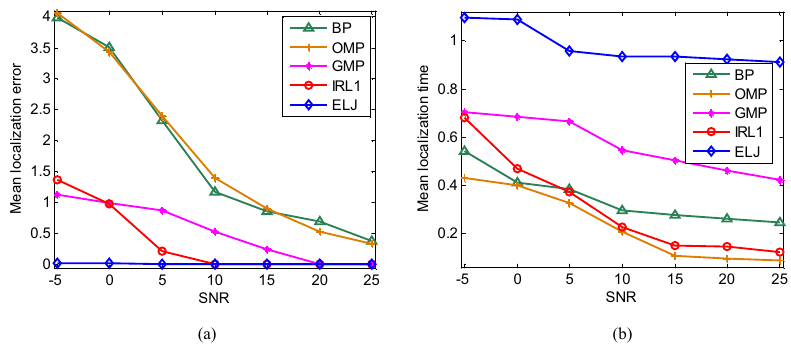
Figure 10. Performance analysis of five recovery algorithms for different measurement noise levels when K = 10, m = 65 and p = 0.8. ( a ) Comparison of the mean localization errors of BP, OMP, GMP, IRL1 and ELJ for different SNR. ( b ) Comparison of the mean localization time of BP, OMP, GMP, IRL1 and ELJ for different